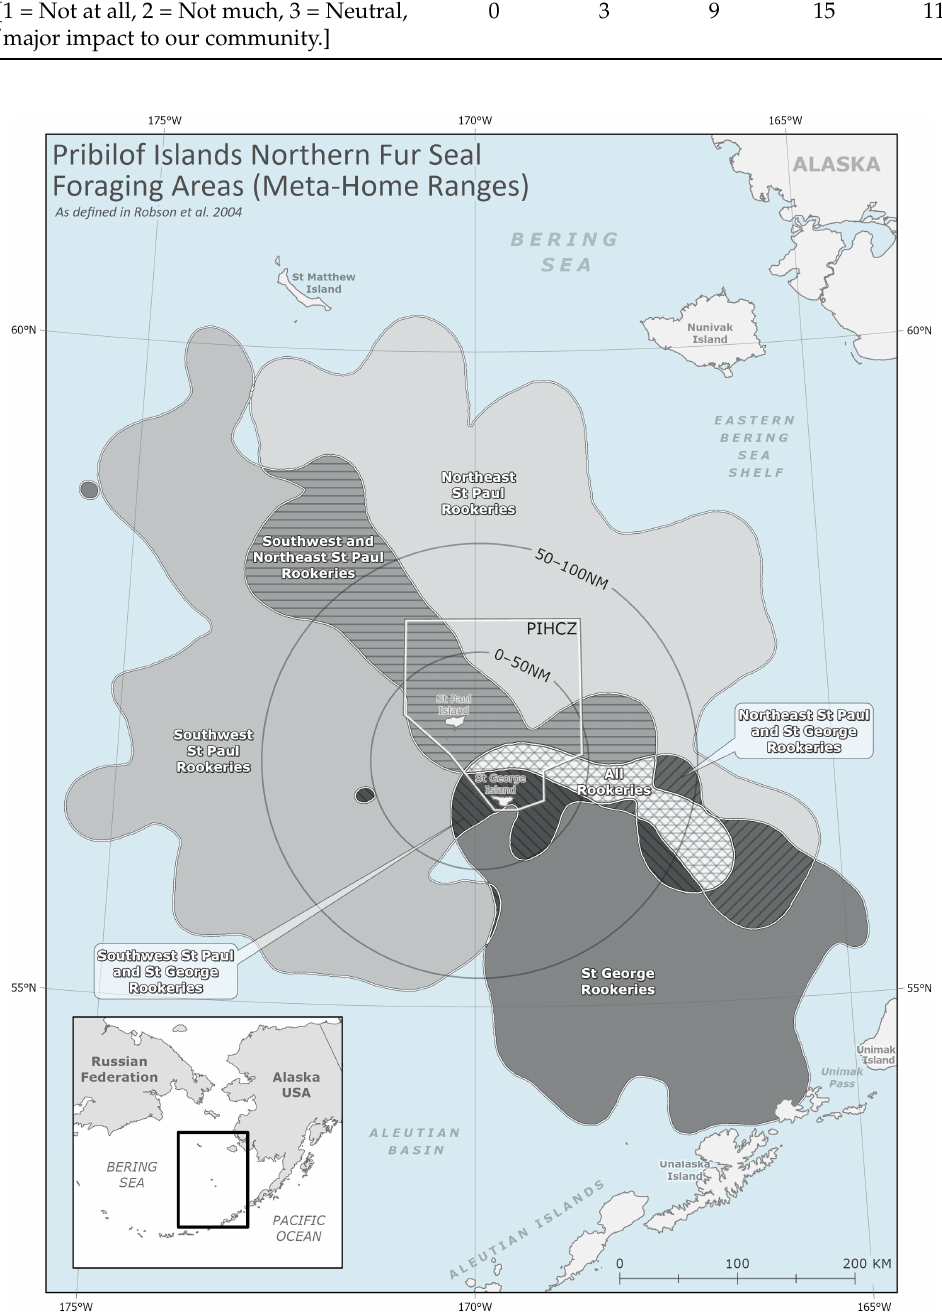
Figure A1. Meta-home ranges (MHRs) and their overlapping areas as defined by Robson et al. (2004).